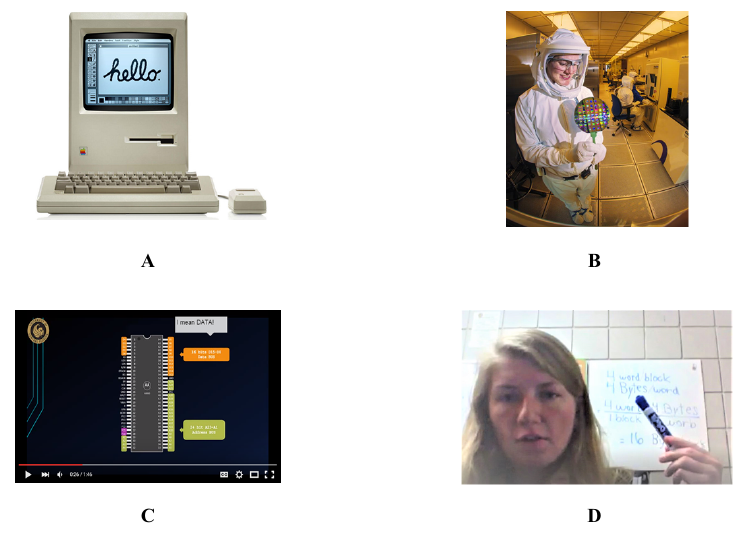
Fig. 1. Archetypes and Student